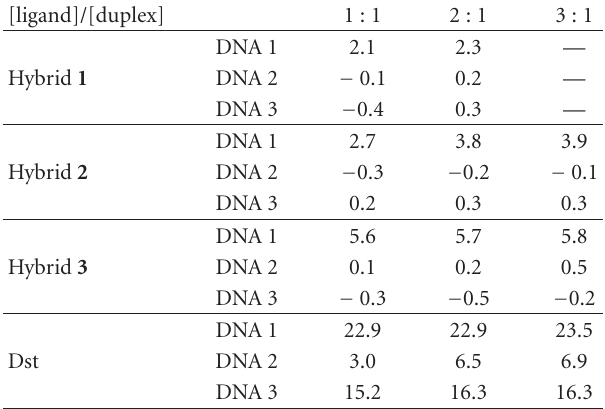
Table 1: Δ T m values ( ◦ C) for the DNA duplexs with ligand (Hybrid 1 , Hybrid 2 , Hybrid 3 , or Dst) at several [ligand]/[duplex] ratios in bu ff er consisting of 10mM sodium phosphate, 10 mM NaCl, and 0.1mM Na 2 EDTA at pH